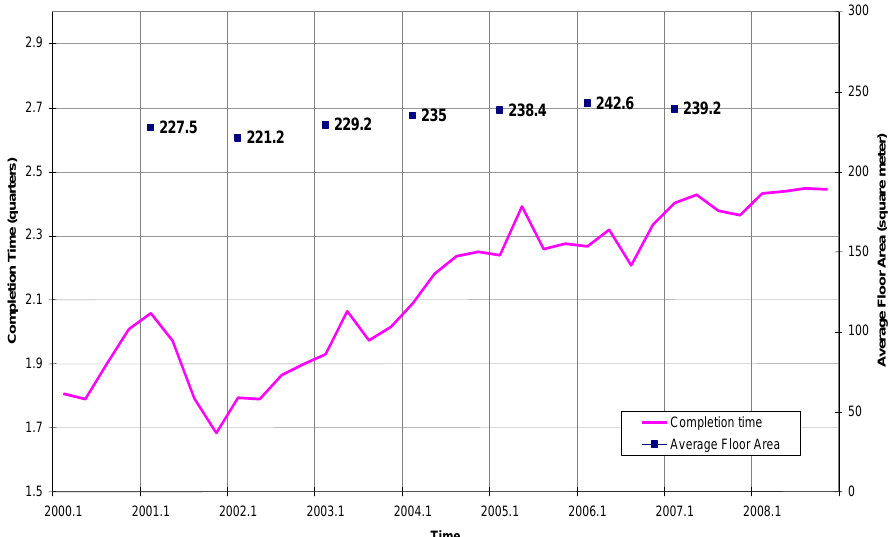
Figure 8: Average floor area and completion time in